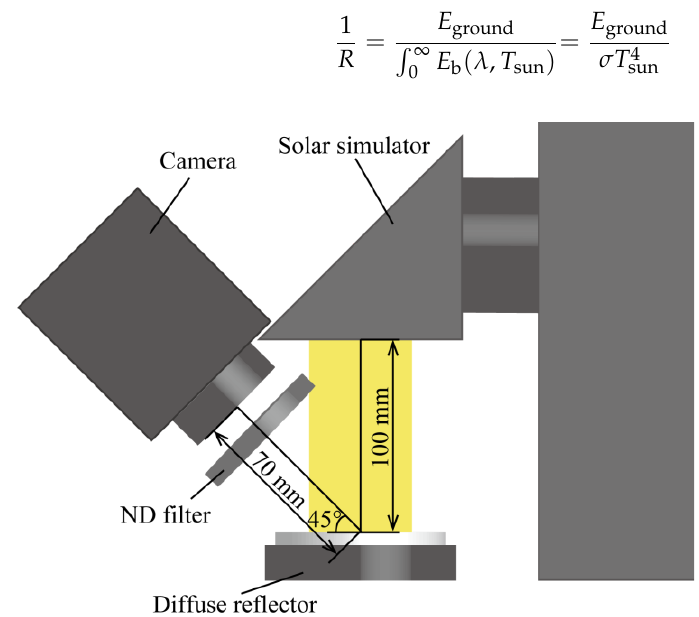
Figure 1. Experimental system for visible and near-infrared light camera calibration.